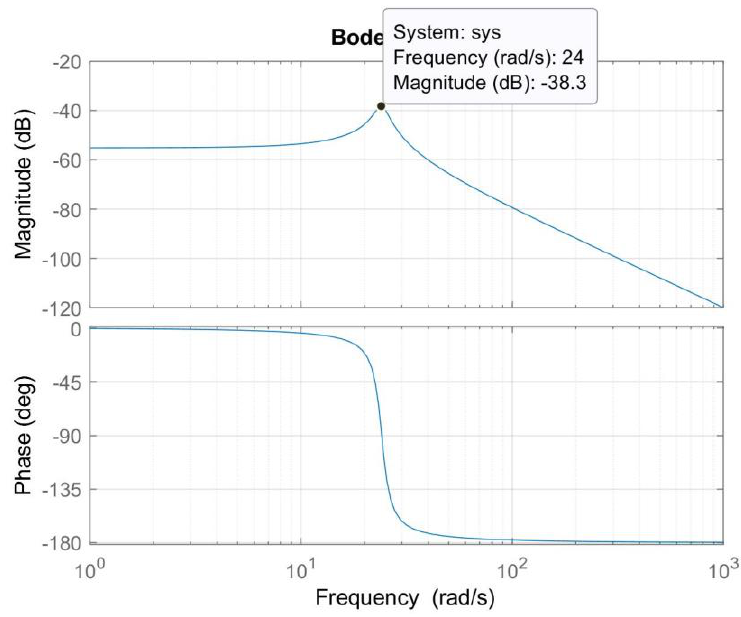
Figure 14. Experimental frequency response.